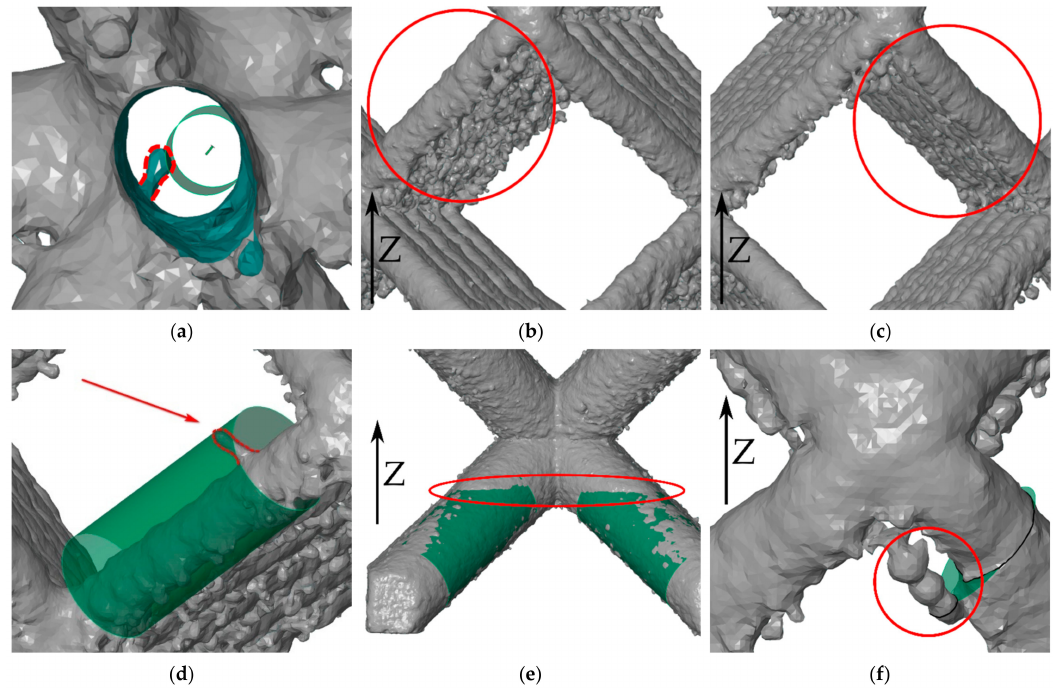
Figure 12. Illustration of lattice structures phenomena. ( a ) Protrusion pointing inside the strut (protrusion highlighted). ( b , c ) Different surface roughness on the down-skin surfaces. ( d ) Protrusion pointing outside the strut (protrusion highlighted). ( e ) Stair effect close to the unit cell node (a green Gauss cylinders are highlighting the stairs effect). ( f ) Weld deposits close to the unit cell node.